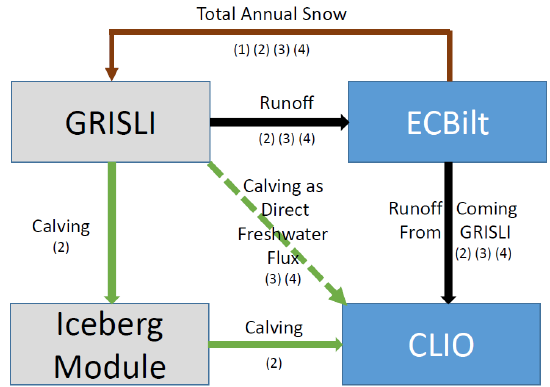
Figure 3. Schematic representation of the water cycle between the atmospheric component ECBilt, the ice-sheet module GRISLI, the iceberg module and the oceanic component CLIO; numbers corre- spond to experiments (1: CTRL; 2: CALV; 3: FWFf; 4: